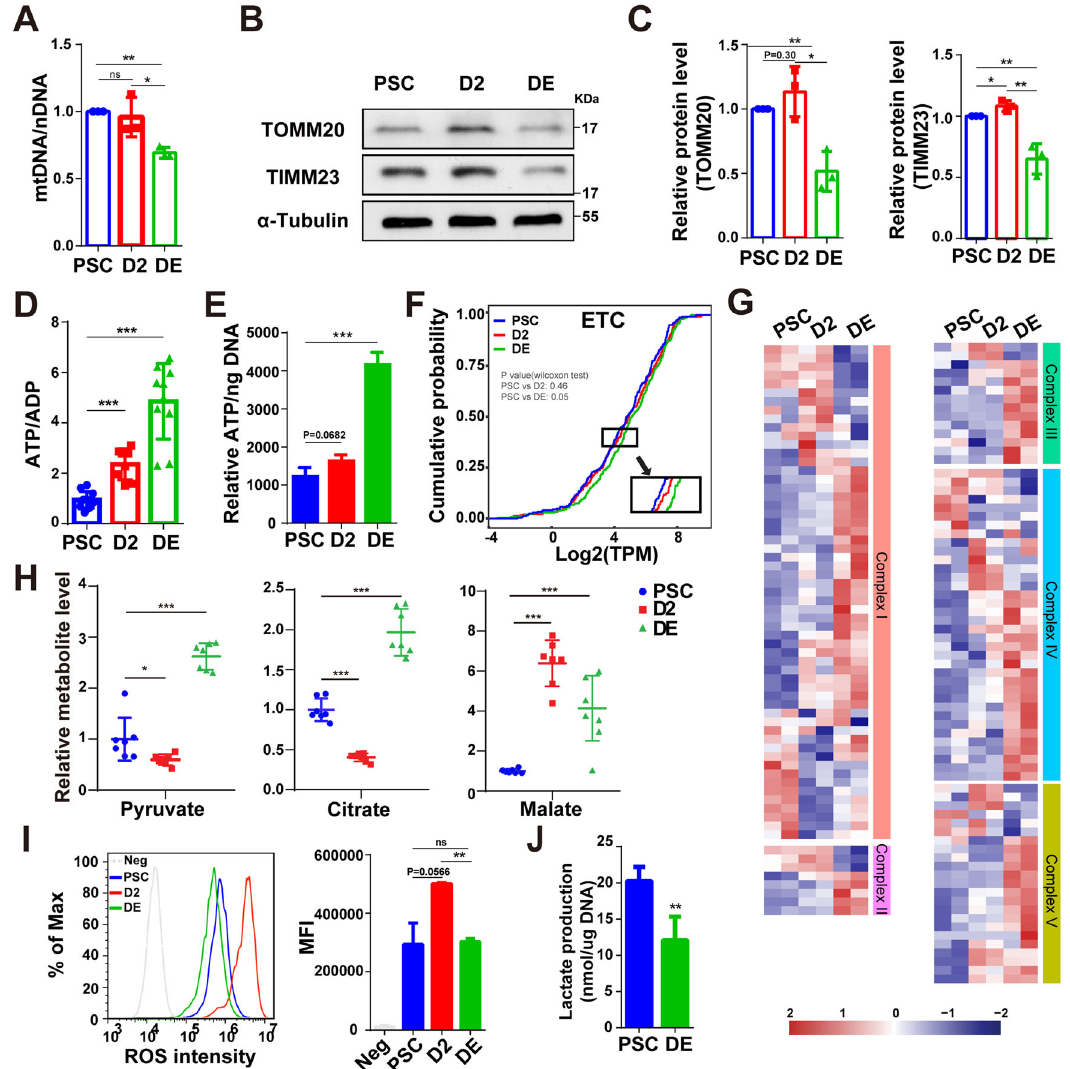
Fig. 2 Mitochondria become more active along with DE differentiation. A The expression of mtDNA relative to the nuclear gene GAPDH in DE differentiation by RT-PCR ( n = 3). B The western blot of TOMM20, TIMM23, and α -tubulin protein during DE differentiation. C Quantitative statistics of the TOMM20 and TIMM23 protein levels (tubulin as the reference protein), corresponding to ( B ) ( n = 3). D , E Total intracellular ATP/ ADP ( D ) ( n = 10) and relative ATP content (normalized with DNA content) ( E ) of cells at three different stages along DE differentiation ( n = 3). F Cumulative distribution curves of Log2(TPM) of ETC subunits-related genes ( n = 124). The P -value was calculated by a Wilcoxon test. G Heatmap showing the expression levels of each complex related gene of ETC by RNA-seq. H Content of representative TCA metabolites in DE differentiation by untargeted metabolomics (normalized to PSCs) ( n = 7). I The intracellular ROS level by FACS (left) and the corresponding mean fl uorescence intensity (MFI) (right) in DE differentiation of ESCs ( n = 3). Neg, negative control. J The assay of lactate production in PSCs and DE cells ( n = 4). All data are shown as mean ± SD. ns, not signi fi cant. * P < 0.05, ** P < 0.01 and *** P <